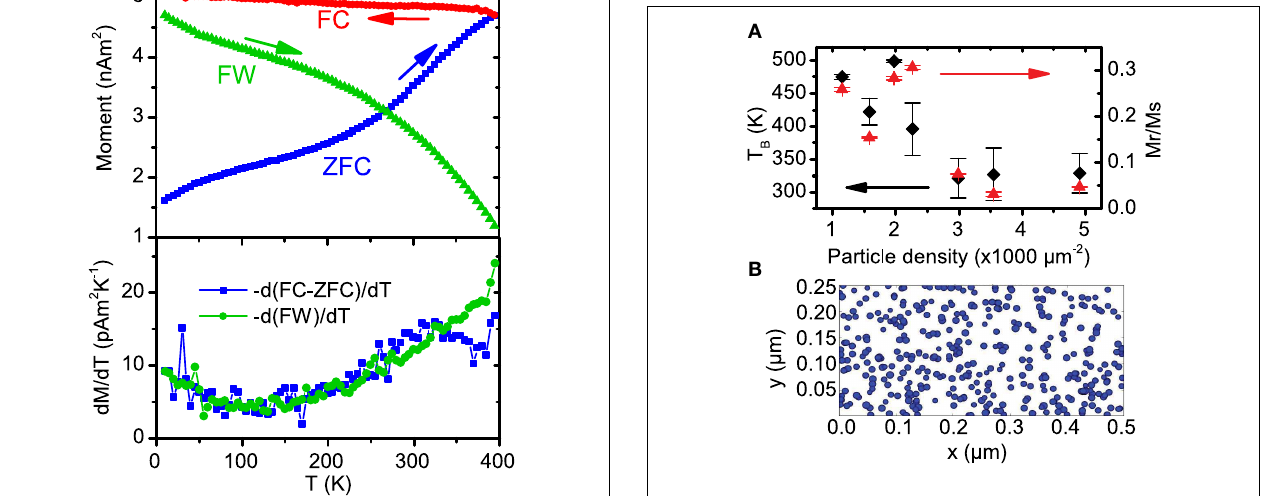
FIGURE 5 | Top panel: ZFC-FC measurements shown for representative sample, plus field warming (FW) plotted in green (see text for details of protocol). Bottom panel: the temperature derivative of the FW and ZFC-FC as indicated, this shows a wide distribution of the particle blocking temperatures.